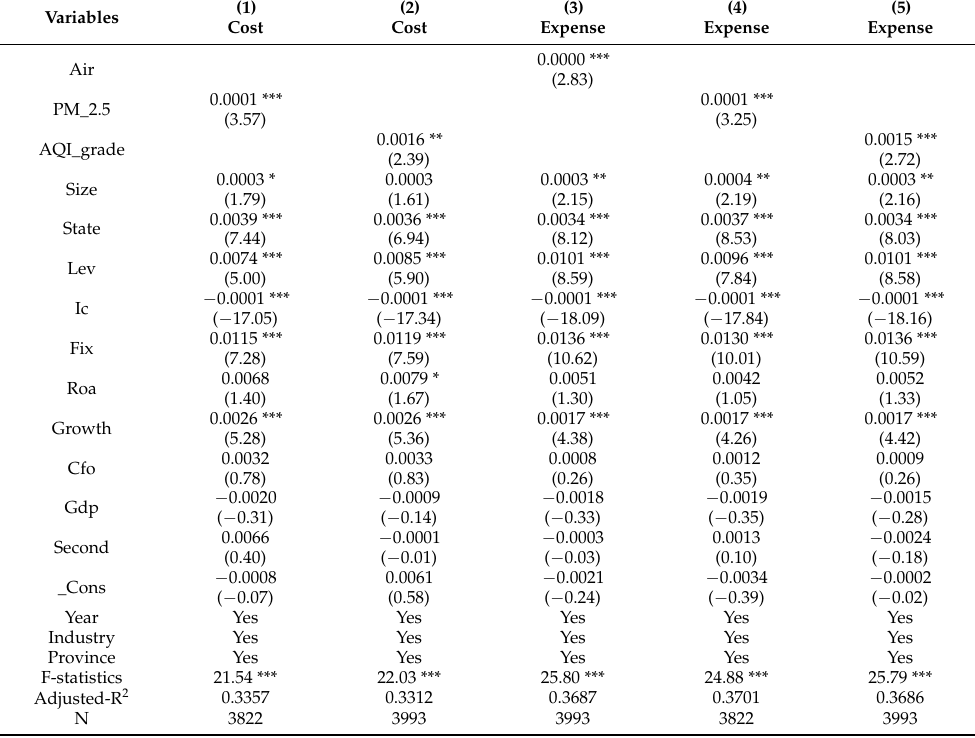
Table 8. Sensitivity test for measurement of air pollution and the cost of